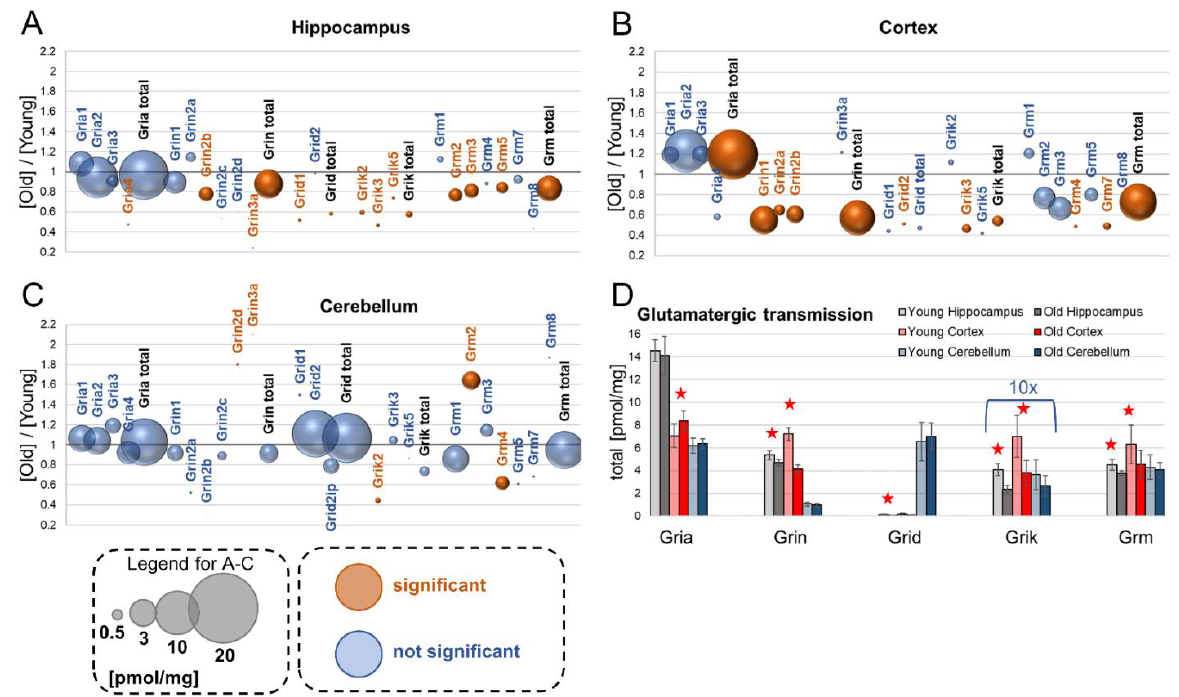
Figure 1. Changes in proteins involved in glutamatergic transmission upon aging. Plots show ratios of protein concentrations in old vs. young brain structures: hippocampus ( A ), cortex ( B ) and cerebellum ( C ). Total concentrations of various receptor families in young and old animals are shown in ( D ) (* p < 0.05). The size of bubbles is proportional to the average protein concentration in the respective old brain structures. Statistically significant differences are shown as the red bubbles.